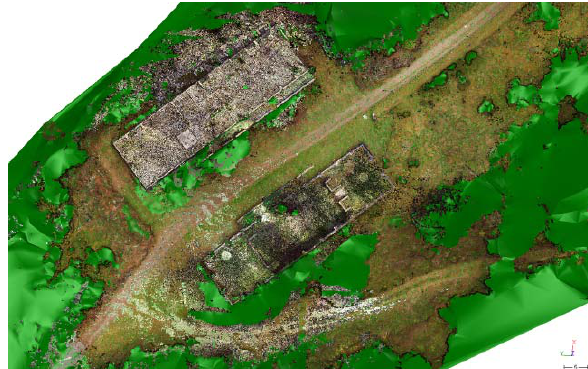
Figure 9 : Extract from the DTM with integration of the point clouds of the forge and the depot.